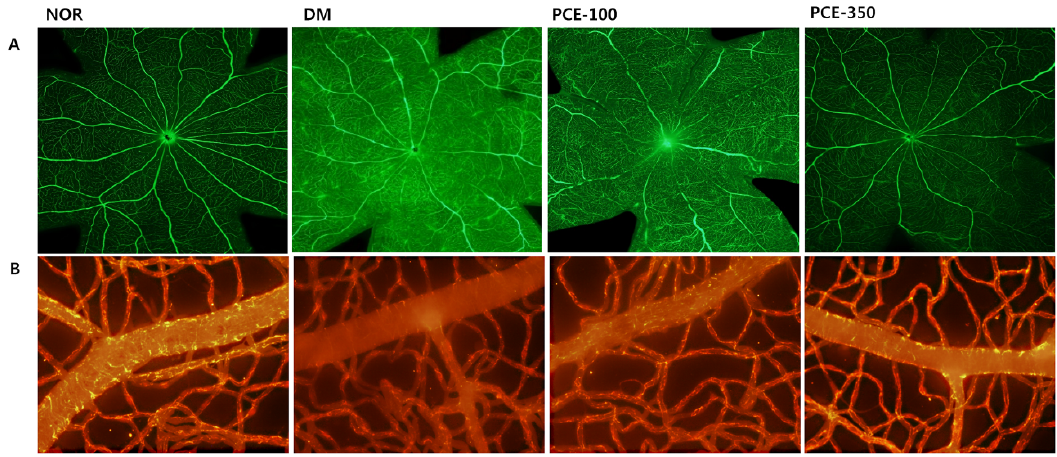
Figure 7. Effect of PCE on diabetes ‐ induced retina vascular permeability. ( A ) Retinal vascular permeability in flat ‐ mounted retinas was analyzed following FITC ‐ BSA injections; and ( B ) immunofluorescence staining for the tight junction marker claudin ‐ 5 (Texas ‐ red) in retinal